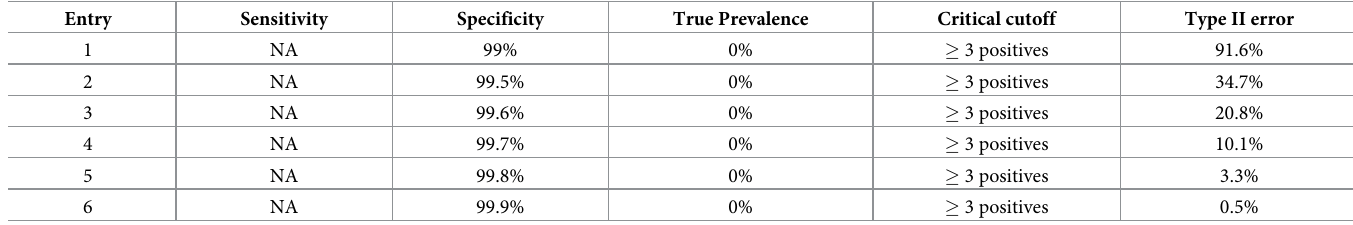
Table 7. Effect of specificity on the Type II error when treatment decisions are based on the cluster-specific results, assuming 30 clusters are surveyed and 100 chil- dren/cluster. No sensitivity assumptions were made. The critical cutoff was � 3 positive tests in at least 1 village. The calculations were made for a true prevalence of 0%. At least 99.7% specificity is required to have a Type II error of < 10%.